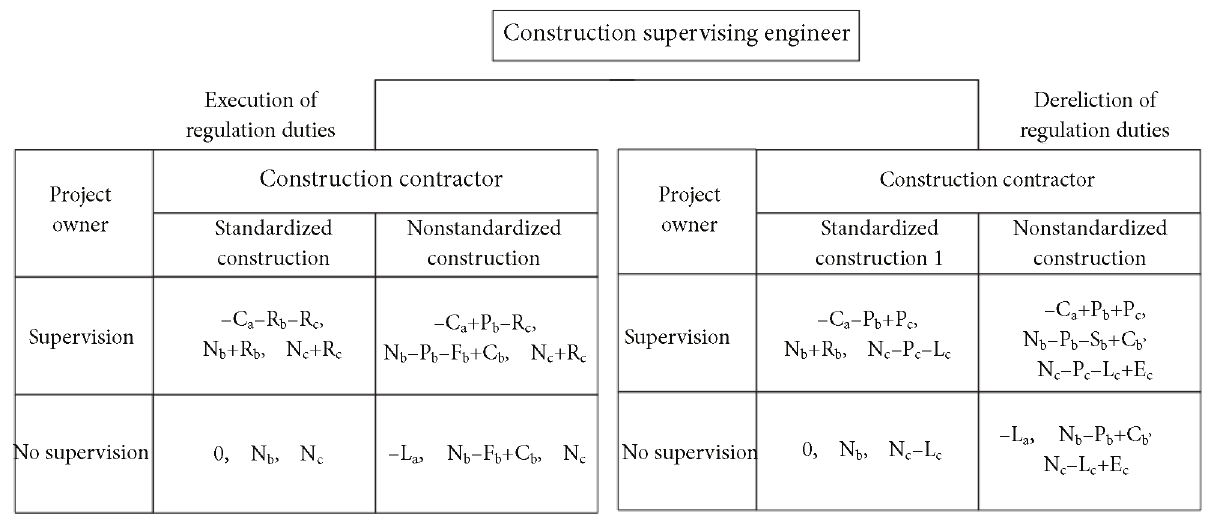
Figure 2. Payoff matrix of the PO, CC and